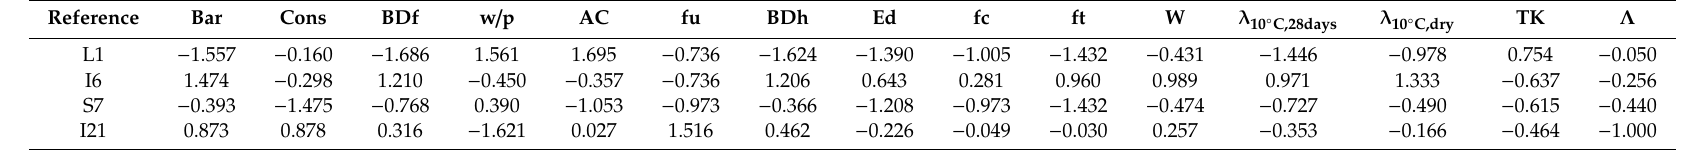
Table 3. Example of the standardisation matrix obtained for some of the